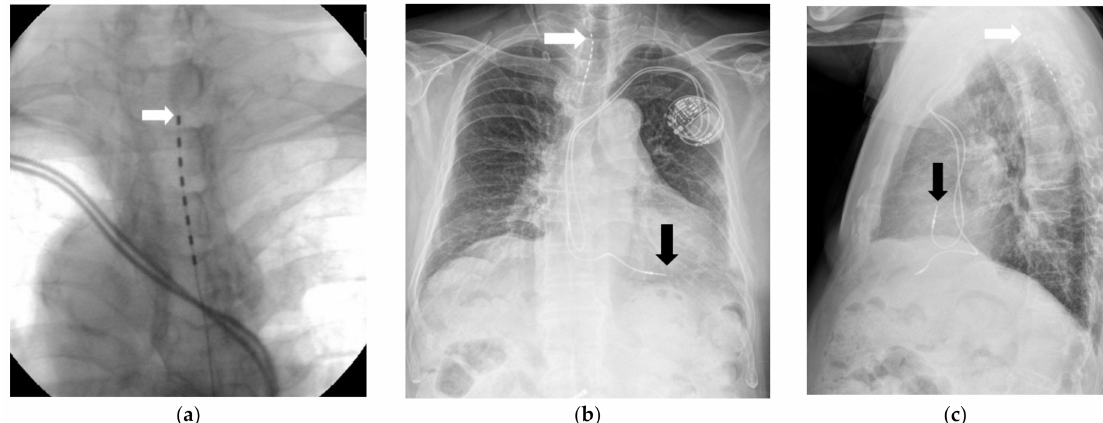
Figure 1. ( a ) Spinal cord stimulation trial 180 days after the onset of rash. The arrow indicates the lead of the spinal cord stimulator. ( b ) A chest postero-anterior view, obtained on the next day, after the spinal cord stimulation trial. The white arrow indicates the lead of the spinal cord stimulator. The black arrow indicates the lead of the permanent cardiac pacemaker. ( c ) The chest lateral view obtained on the next day after the spinal cord stimulation trial. The shortest distance between the lead of the spinal cord stimulator and the lead of the cardiac pacemaker was 163.41 mm. The white arrow indicates the lead of the spinal cord stimulator. The black arrow indicates the lead of the permanent cardiac